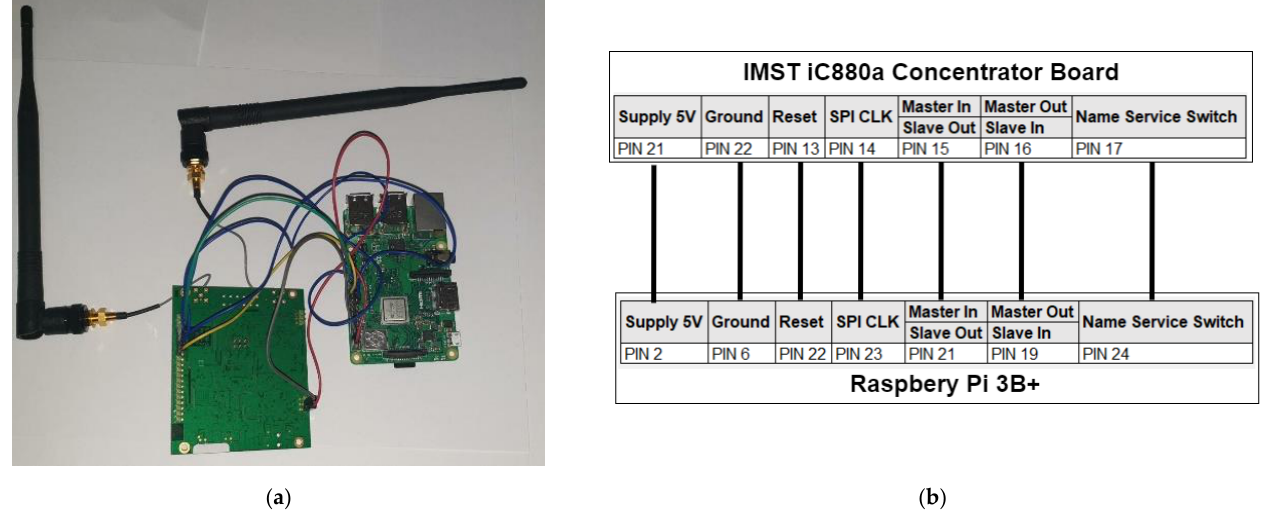
Figure 6. LoRaWAN Gateway ( a ) Hardware View of the Implementation. ( b ) Connection Diagram for the LoRaWAN Gateway.